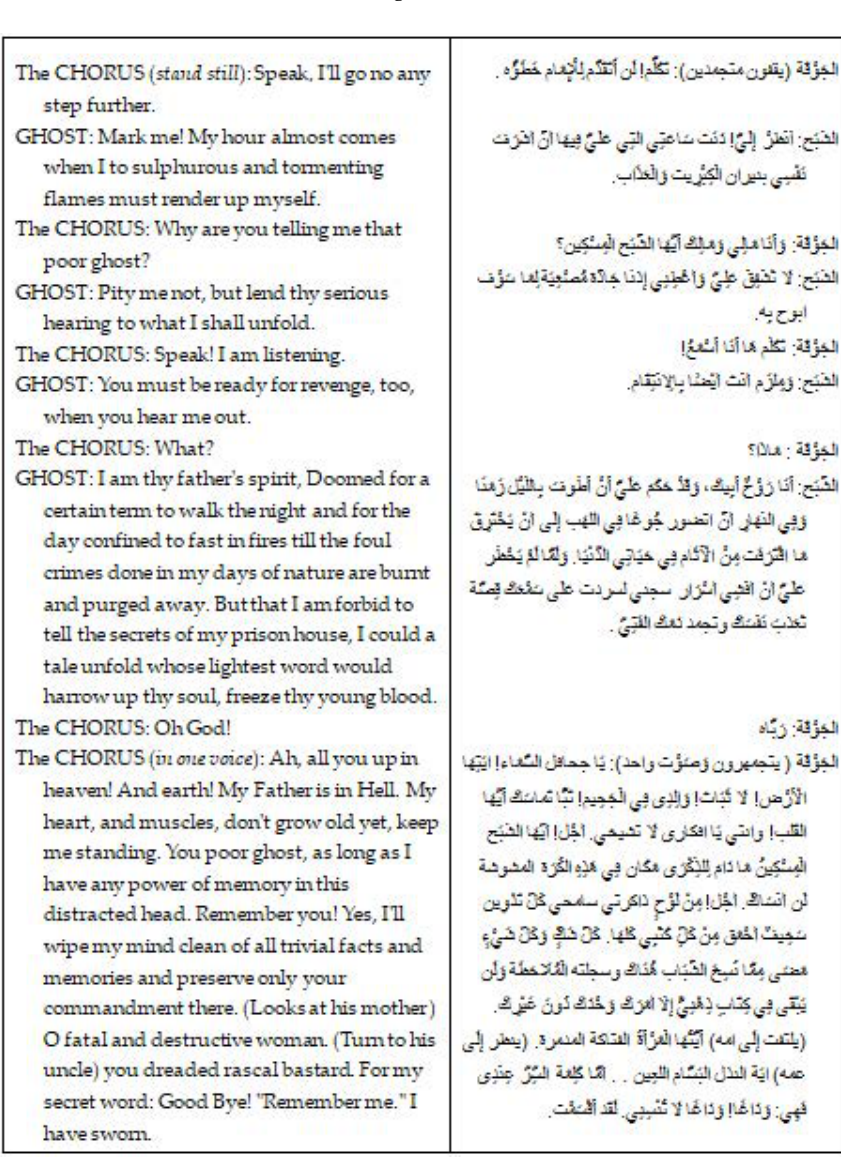
Figure 5. The scene in which the Hamlet chorus first encounter the ghost in Act I Scene 5. The text is transcribed from a video of the production posted on YouTube (See El-Basha 2013).